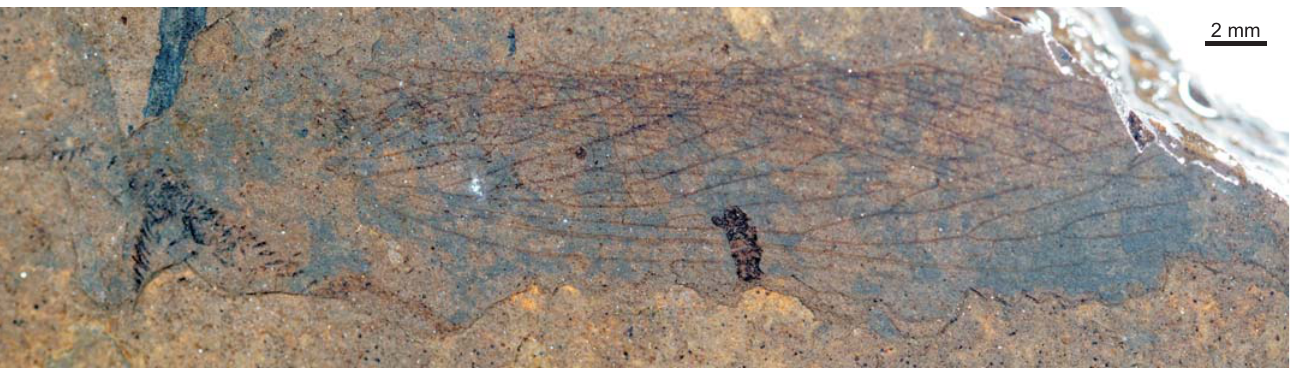
Fig. 3. Habitus of chaeteessid mantodean Arvernineura insignis Piton, 1940, MNT NEL1656, Menat, France,